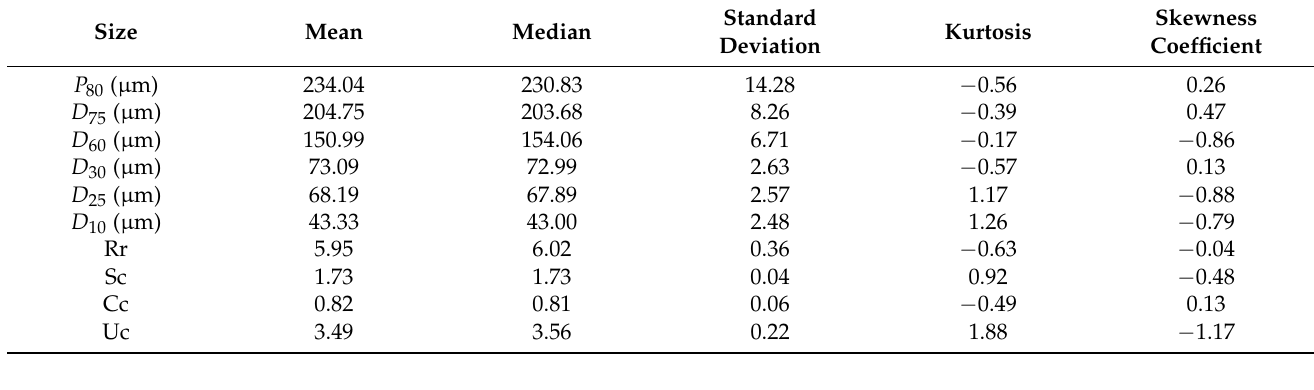
Table A13. Descriptive statistics for ore a under 12 min grinding for descriptive parameters of PSD.